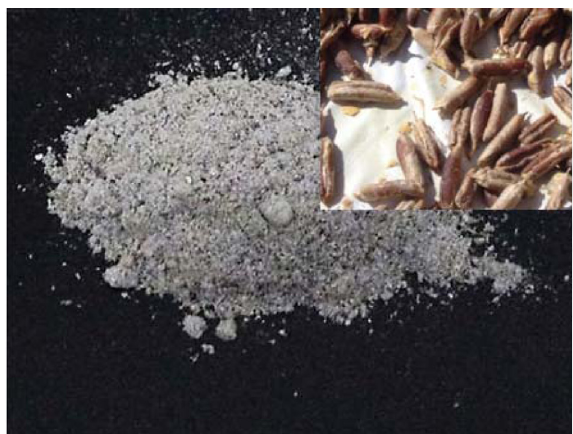
Fig. 3. Date seed ash (DSA); up-right-side: original date seed (Mirhosseini et al. 2016) Table 2. Chemical composition of the three additives (%)